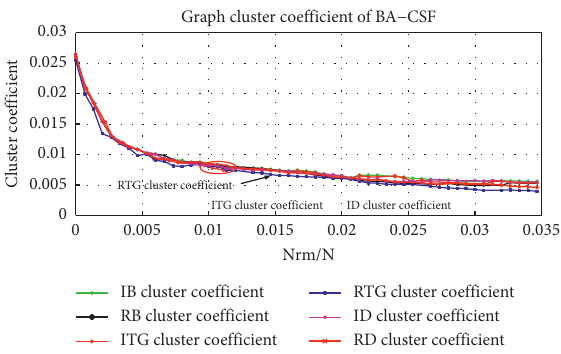
Figure 4: C G �( V,E ) result of BACSF.